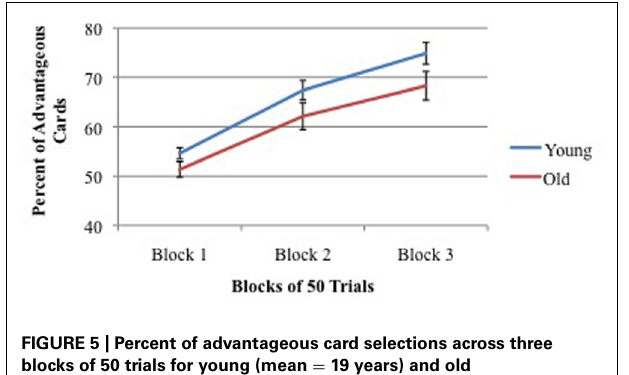
FIGURE 5 | Percent of advantageous card selections across three blocks of 50 trials for young (mean = 19 years) and old (mean = 59 years) participants. Vertical bars indicate